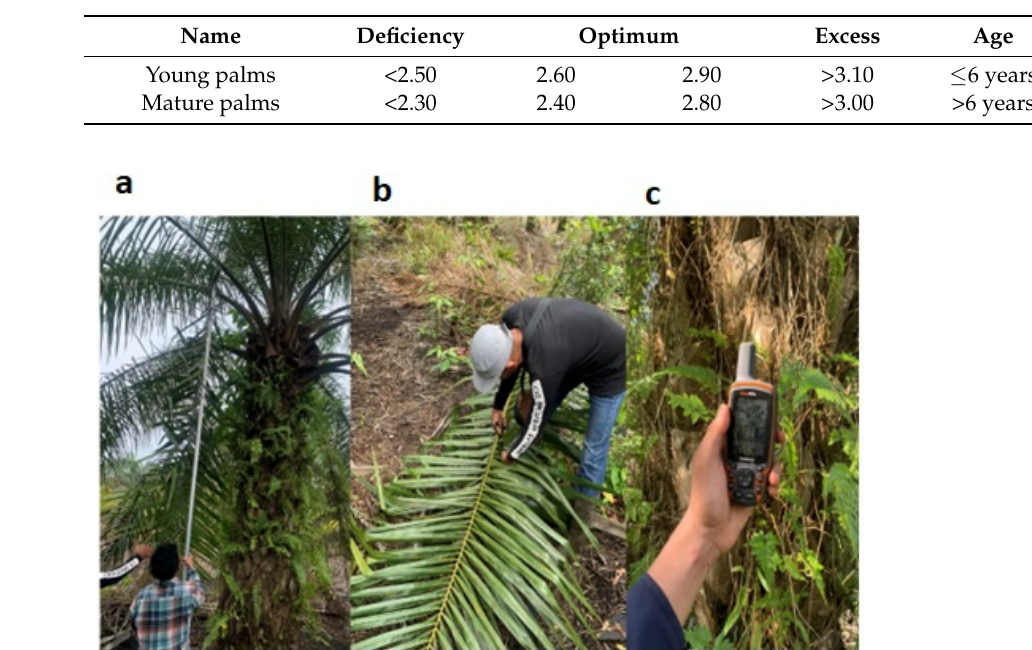
Figure 1. Taking of Leaf Sampling Units (LSU) in oil palm plantations. ( a ) The 17th leaf midribs were chosen and collected from oil palm plants. ( b ) Taking of four leaves from the flat endpoint in the centerpiece of the palm midribs. ( c ) Recording the GPS coordinates of the location of the palm trees.